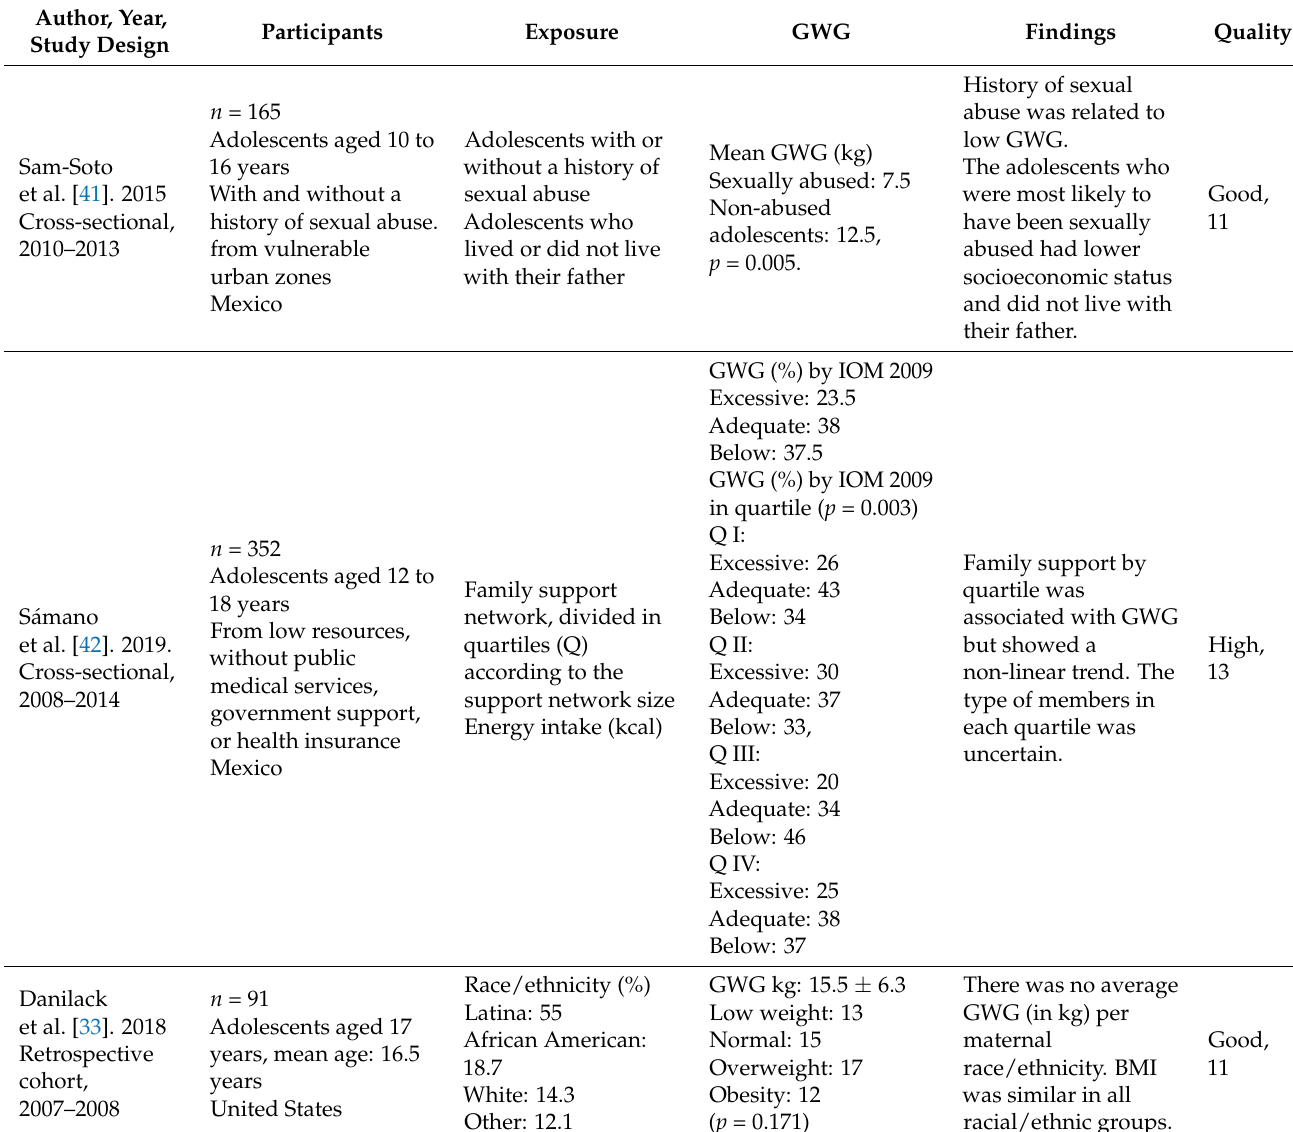
Table 2. Synthesis of studies on family and sociocultural characteristics and gestational weight gain in pregnant